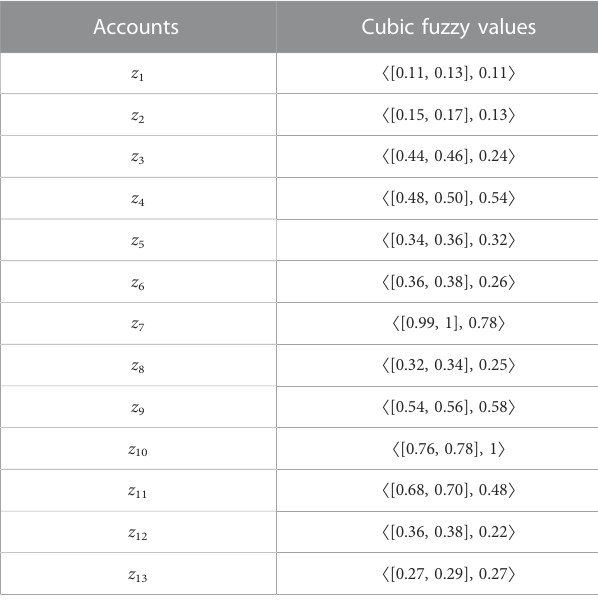
TABLE 3 The cubic fuzzy values of each account.